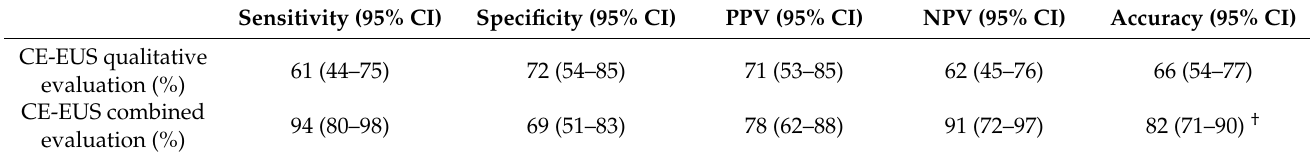
Table 6. The diagnostic performance of contrast-enhanced endoscopic ultrasound with qualitative and quantitative evaluations compared with qualitative evaluation.